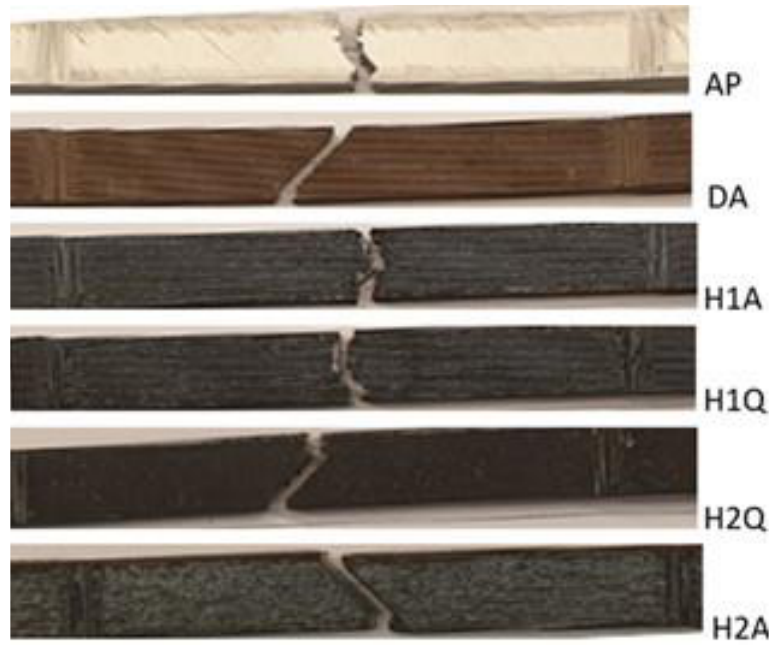
Figure 14. Fracture profile of material failure during the tensile test.